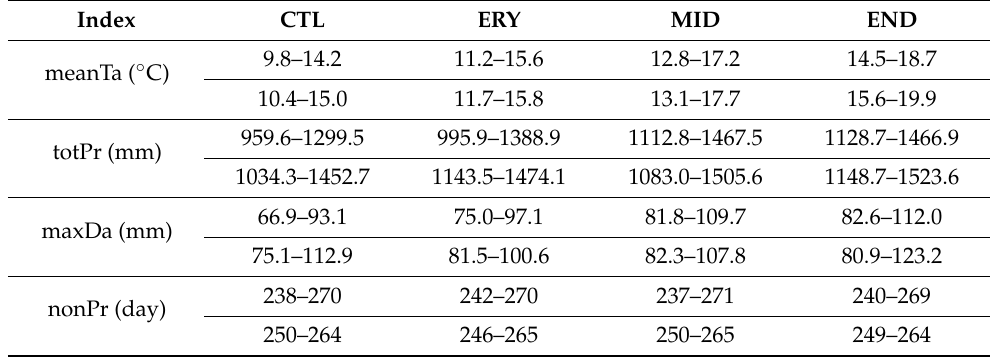
Table 3. The minimum and maximum of the CM values from MCMC simulations values over 40 locations in scenario RCP 8.5 (the first row of each index) for CMIP5 and scenario SSP5-8.5 (the second row of each index) for